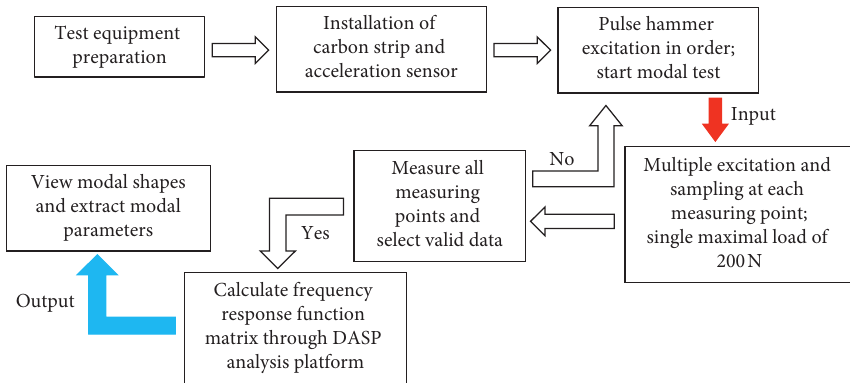
Figure 5: Modal test flow of carbon